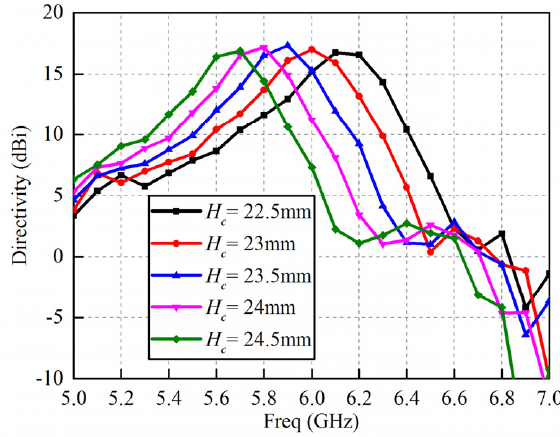
Figure 5. Gain ‐ frequency response against H c for the FRPA with a traditional planar superstrate.